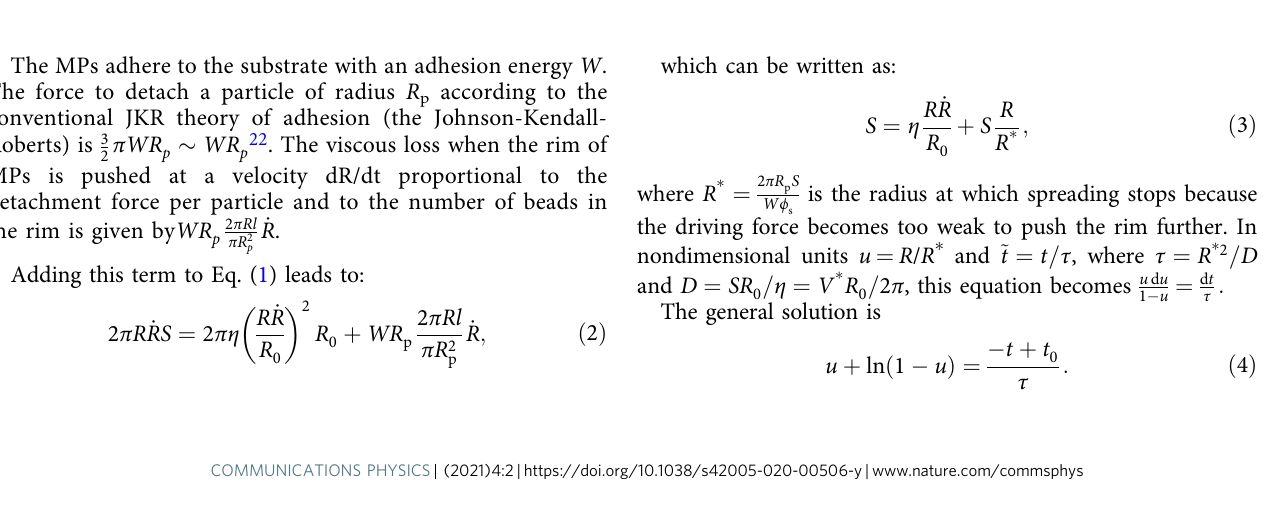
Fig. 3 Characterization of the dynamics of spreading. a Spread area versus time for Ps-4.5 microparticles (MPs) and Ps-10 at increasing surface fractions Φ fi tted by the theoretical law (Eq. (4)) where V * is the spreading velocity of cell aggregates. b Characteristic time and radius at which spreading (cid:4) (cid:5) S . Data are versus R *2 ( R * being the radius at which the stops, as a function of MP surface fraction, for Ps-4.5 and Ps-10. c Characteristic time τ ¼ R (cid:2) 2 D ¼ R (cid:2) 2 2 π V (cid:2) R 0 spreading stops) for Ps-4.5 and Ps-10. d Dynamics of spreading for light polystyrene MPs, where V * is measured in the linear regime before the spreading slows down. The dashed line highlights V * of the control cell aggregates for comparison. e Spread area versus time for SiO 2 MPs with a diameter of 5, 10, and 20 μ m at increasing MP surface fractions. Data are fi tted by a linear fi t. f Dynamics of spreading for heavy silica MPs, where the cells spread on the MPs. V * is nearly independent upon Φ s . Error bars represent the standard deviation of n = 10